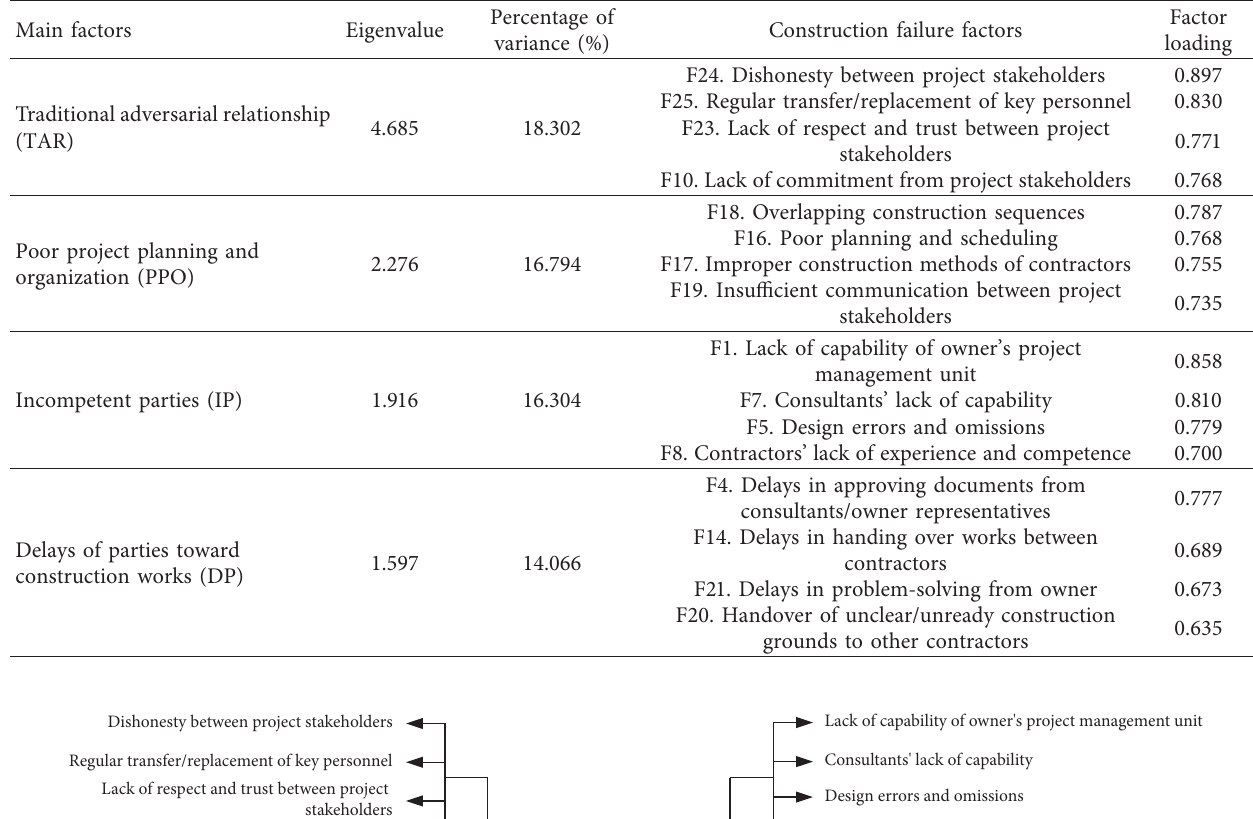
Table 5: The results of the factor analysis.